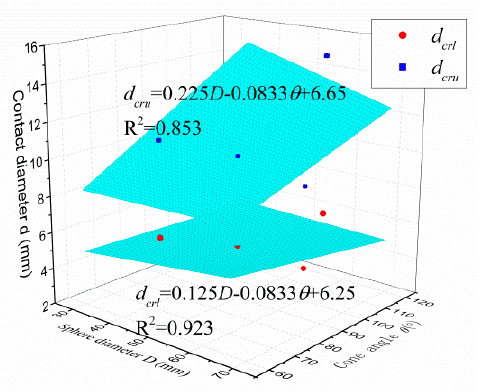
Figure 16. Relationship between critical normal force F cr and sphere diameter D .